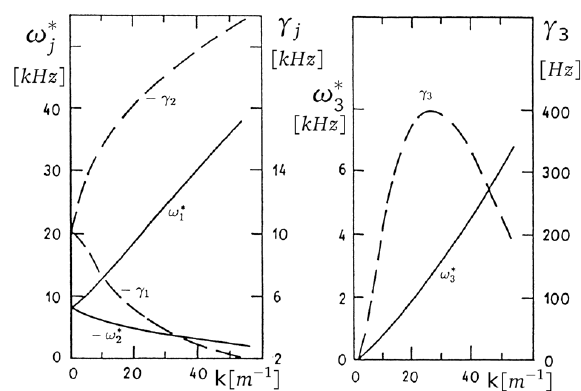
+ k y V ey o , γ i j